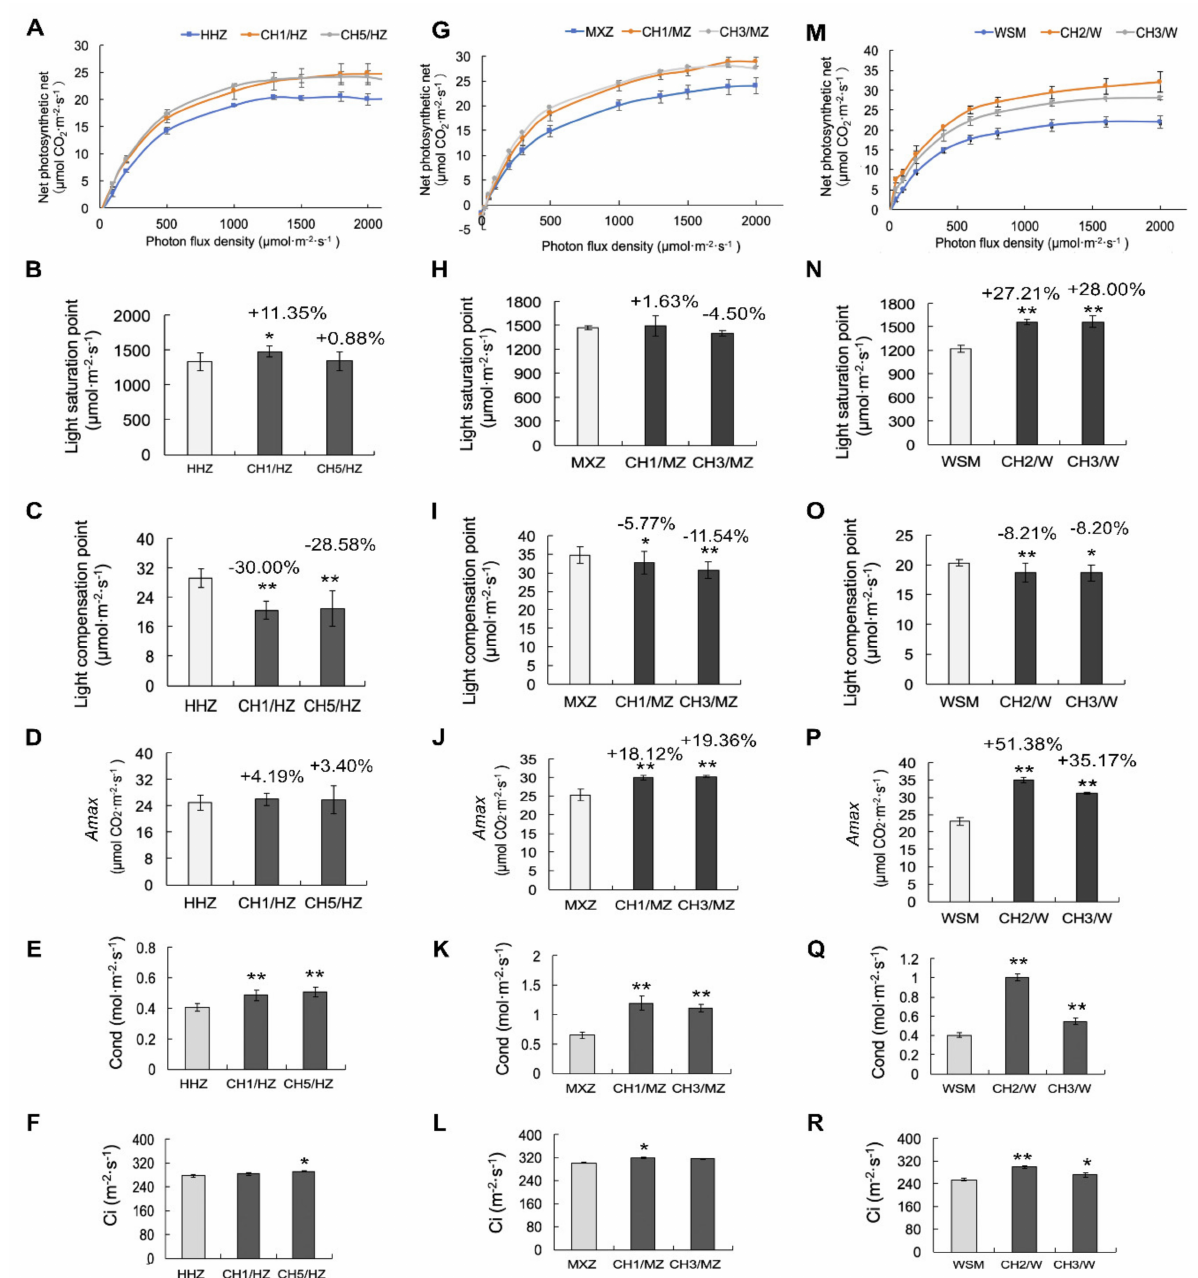
Figure 4. Analysis of photosynthesis properties of HHZ, MXZ, WSM, and OsHXK1-Cas9 plants. ( A , G , M ), Light-response curves were generated for HHZ, MXZ, WSM, CH1/HZ, and OsHXK1-Cas9 plants under normal air conditions. ( B – D , H – J , M – P ), Statistics of the LSP, LCP, and A max of HHZ, MXZ, WSM, and CH1/HZ, and OsHXK1-Cas9 plants. All measurements were performed using the flag leaves of rice at the flowering stage. Shown are the means ± SDs; n = 3; *, 0.01 ≤ p < 0.05; **, 0.001 ≤ p < 0.01, according to Student’s t -test. ( E , F , K , L , Q , R ), Cond and Ci of HHZ, MXZ, WSM, and OsHXK1-Cas9 plants. Shown are the means ± SDs ( n = 3); *, 0.01 ≤ p < 0.05; **, 0.001 ≤ p < 0.01, according to Student’s t